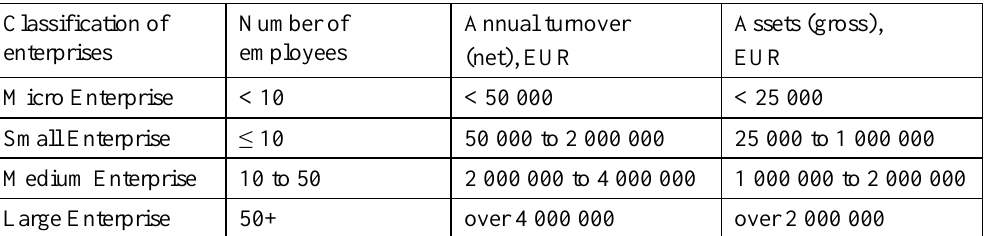
Table 8. Classification of Enterprises by Size in